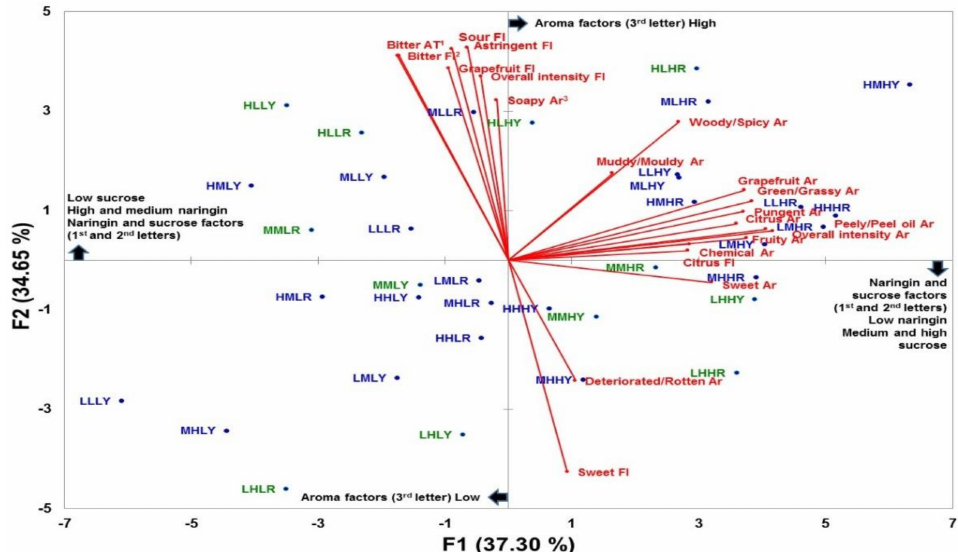
Figure 1. Principal Component Analysis (PCA) of the sensory profiles of the 36 grapefruit-like beverages. The vectors indicate the loadings for sensory attributes while the position of the sample codes indicate the score values. The four-letter codes indicate levels of naringin (1st letter: L = Low, M = Medium, or H = High), sucrose (2nd letter: L = Low, M = Medium, or H = High), aroma (3rd letter: L = Low, or H = High) and color (4th letter: R = red or Y = yellow). Sensory attributes 1 AT = Aftertaste, 2 Fl = Flavor, 3 Ar = Aroma. Beverages in green font were selected for the consumer